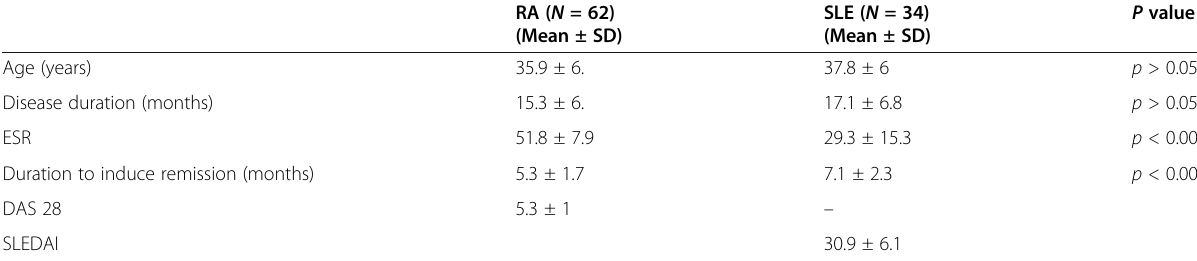
Table 1 Clinical and demographic data of the studied groups